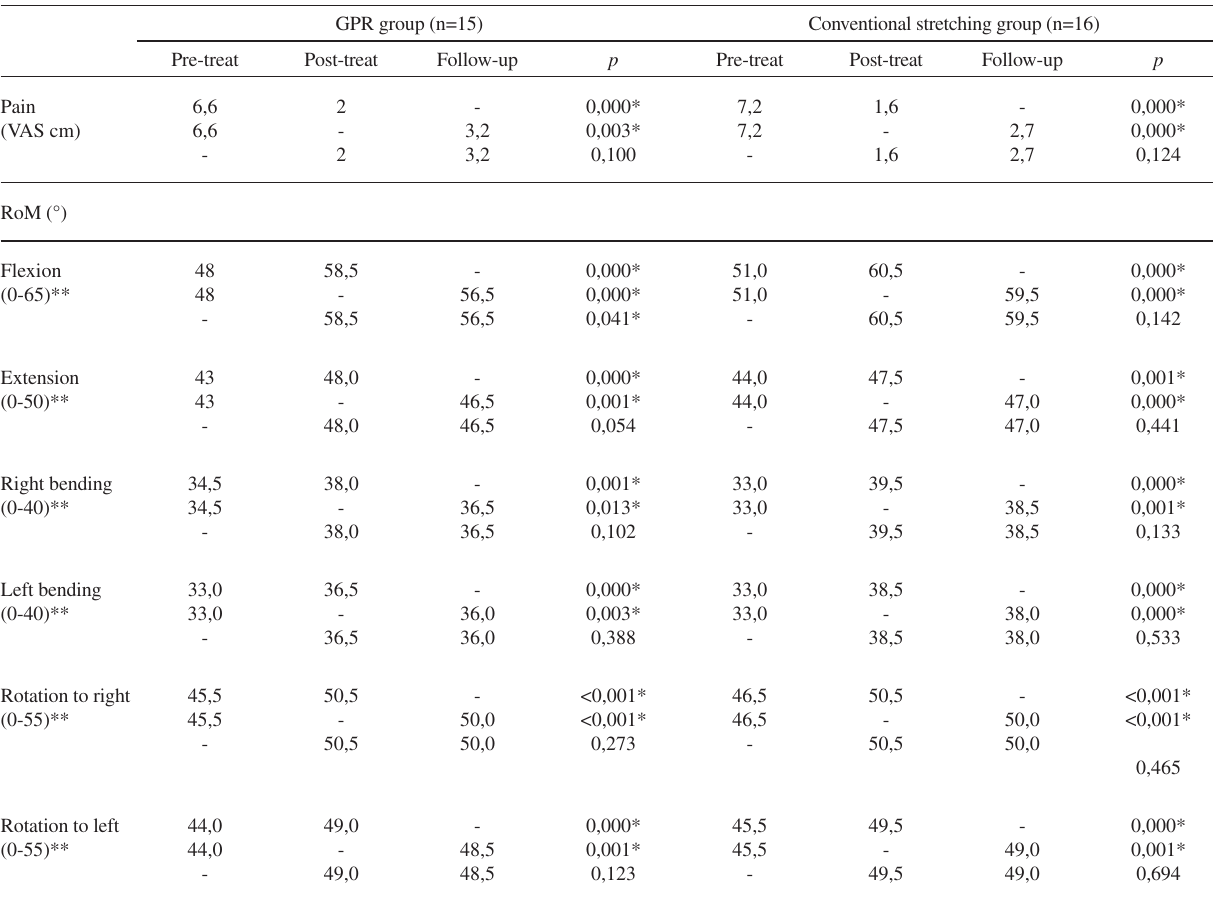
Table 2 - Pain and range of motion (RoM) mean values of both groups at pre- and post-treatment evaluations and at follow- up, and p values for the comparisons pre X post, pre X follow-up, and post X